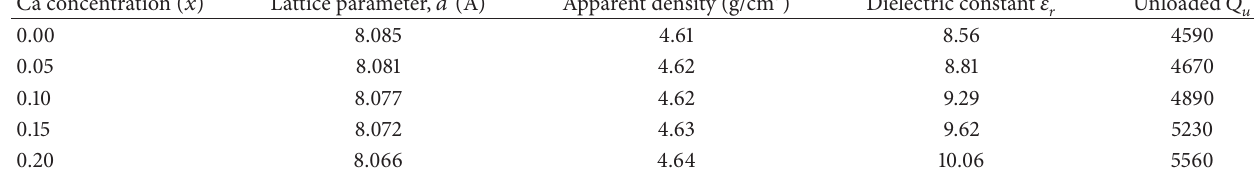
Table 1: Microwave dielectric properties of Ca 𝑥 Zn (1−𝑥) Al 2 O 4 thin films annealed at 500 ∘ C for 1h.